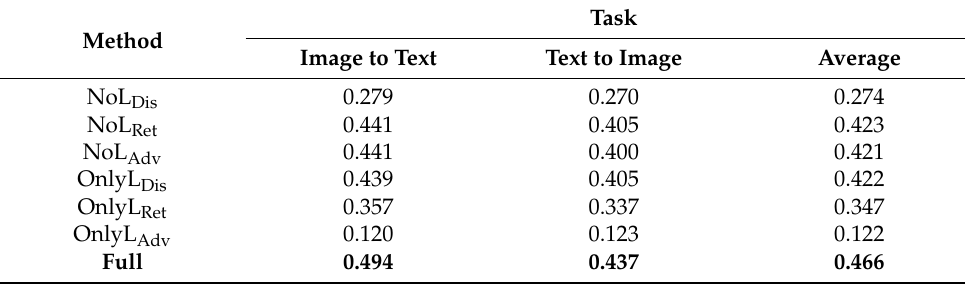
Table 4. The mAP scores of the cross-modal retrieval performance on the Wikipedia dataset.